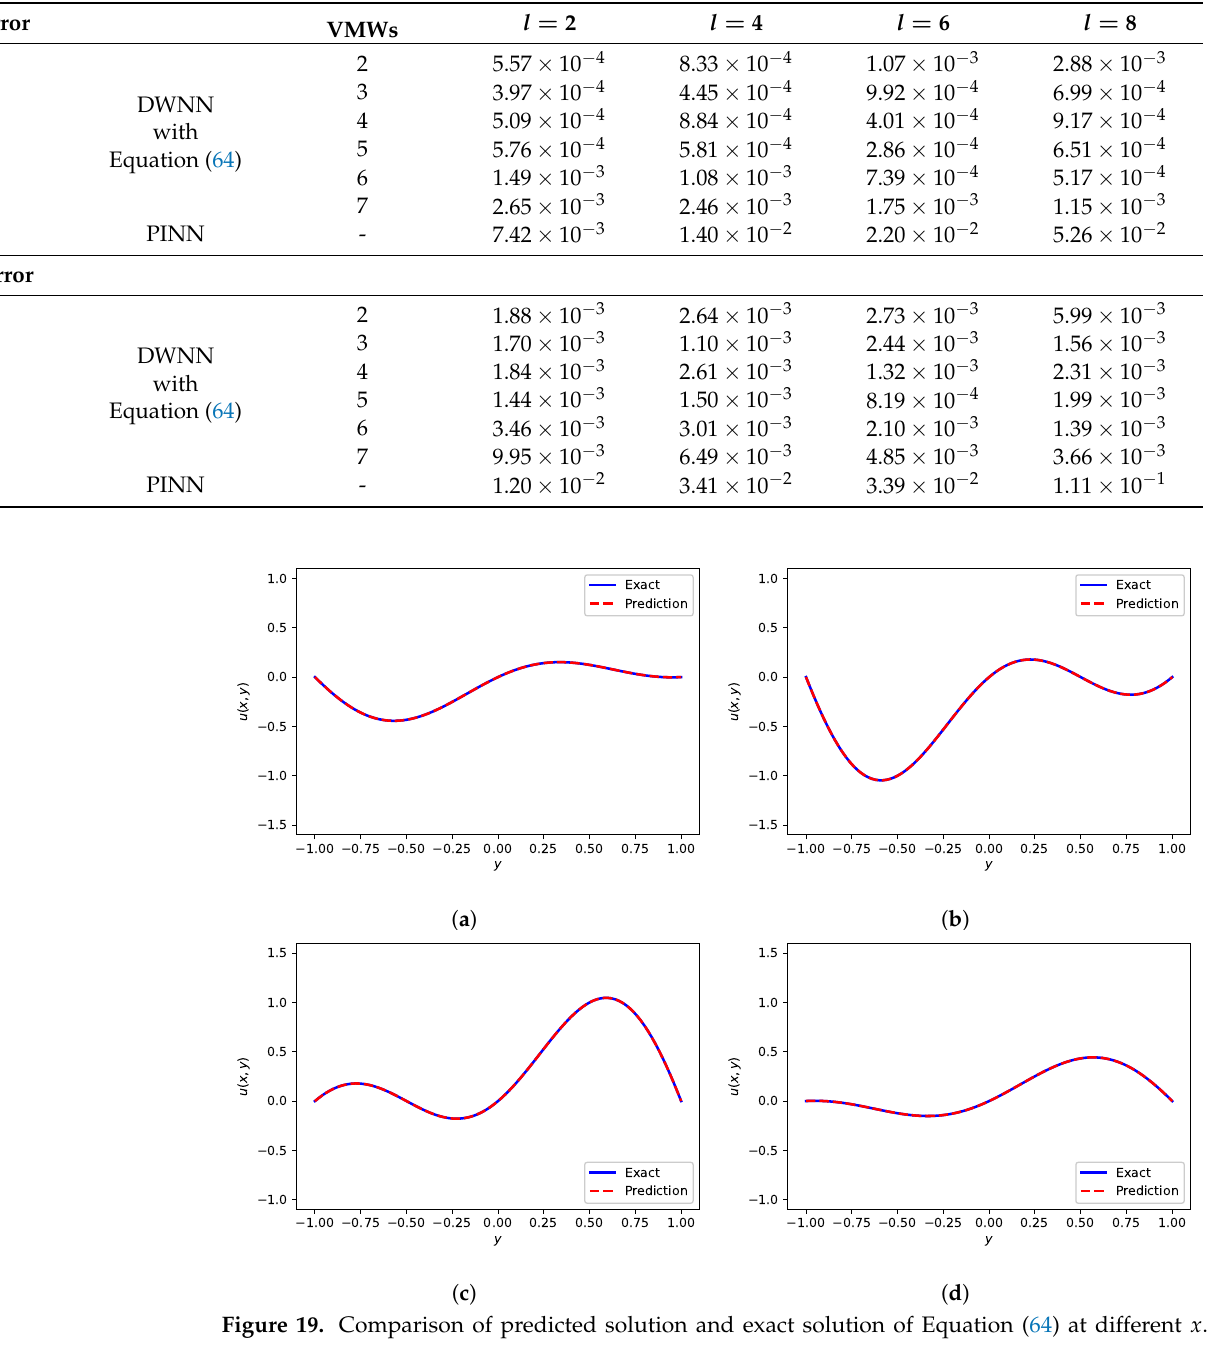
Table 9. The L 2 errors and L ∞ errors for 2D Helmholtz.